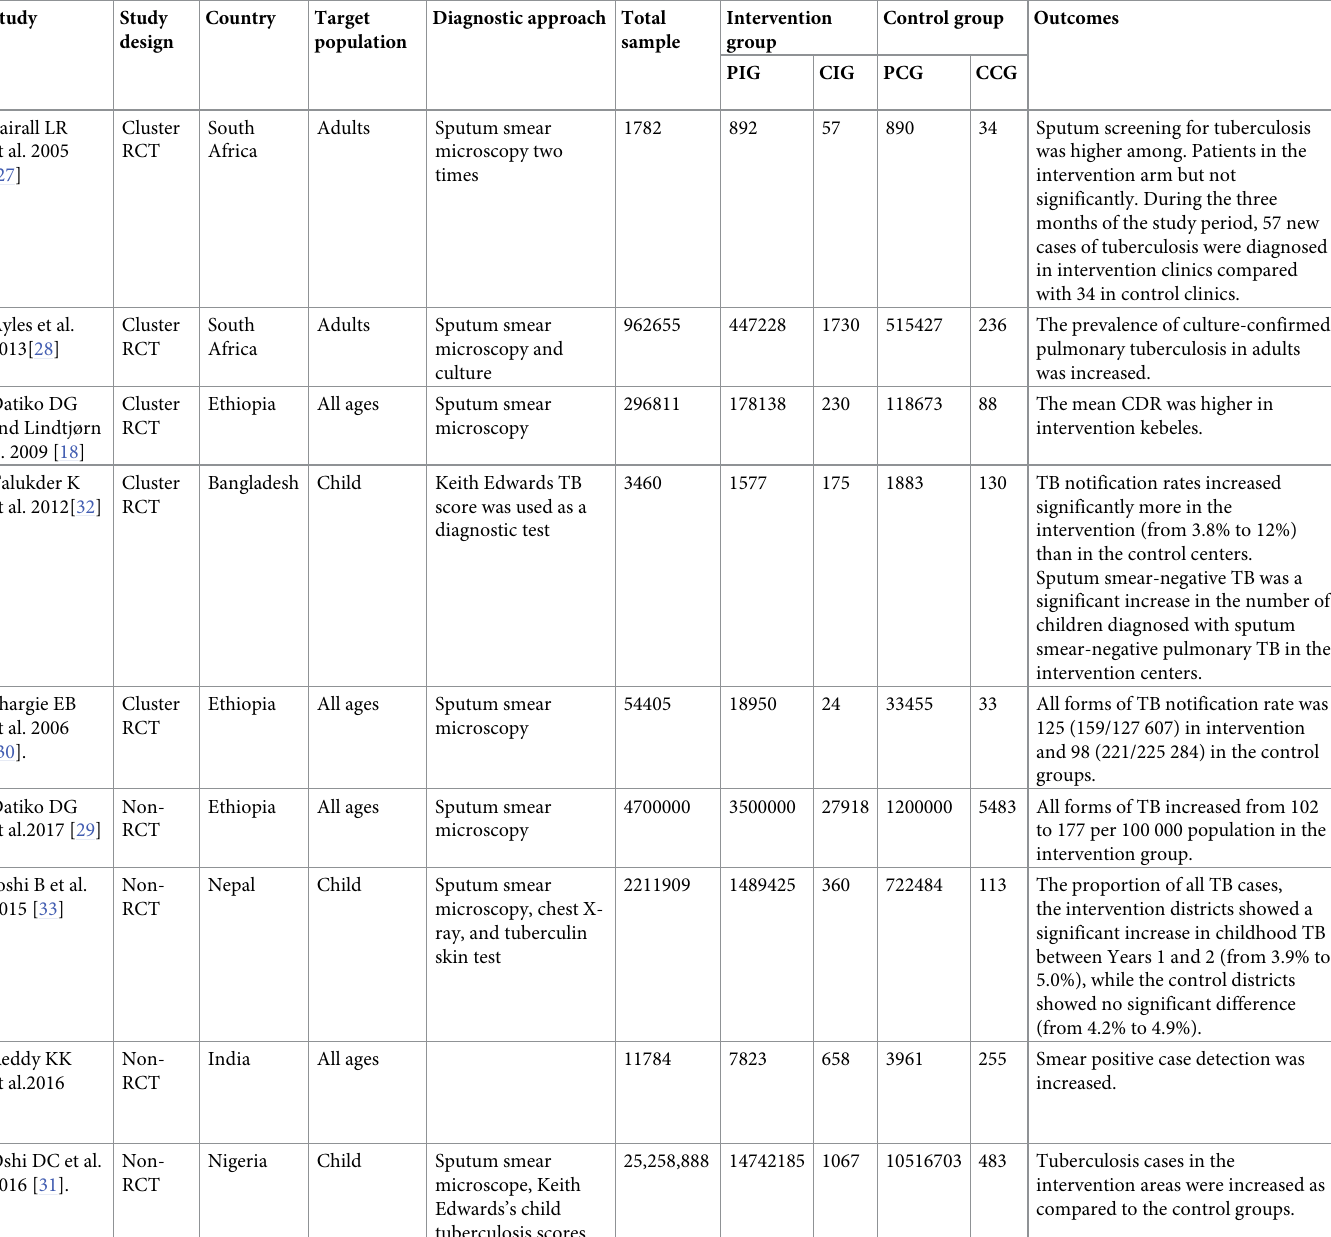
Table 1. The characteristics of the studies included in the systematic review and meta-analysis.